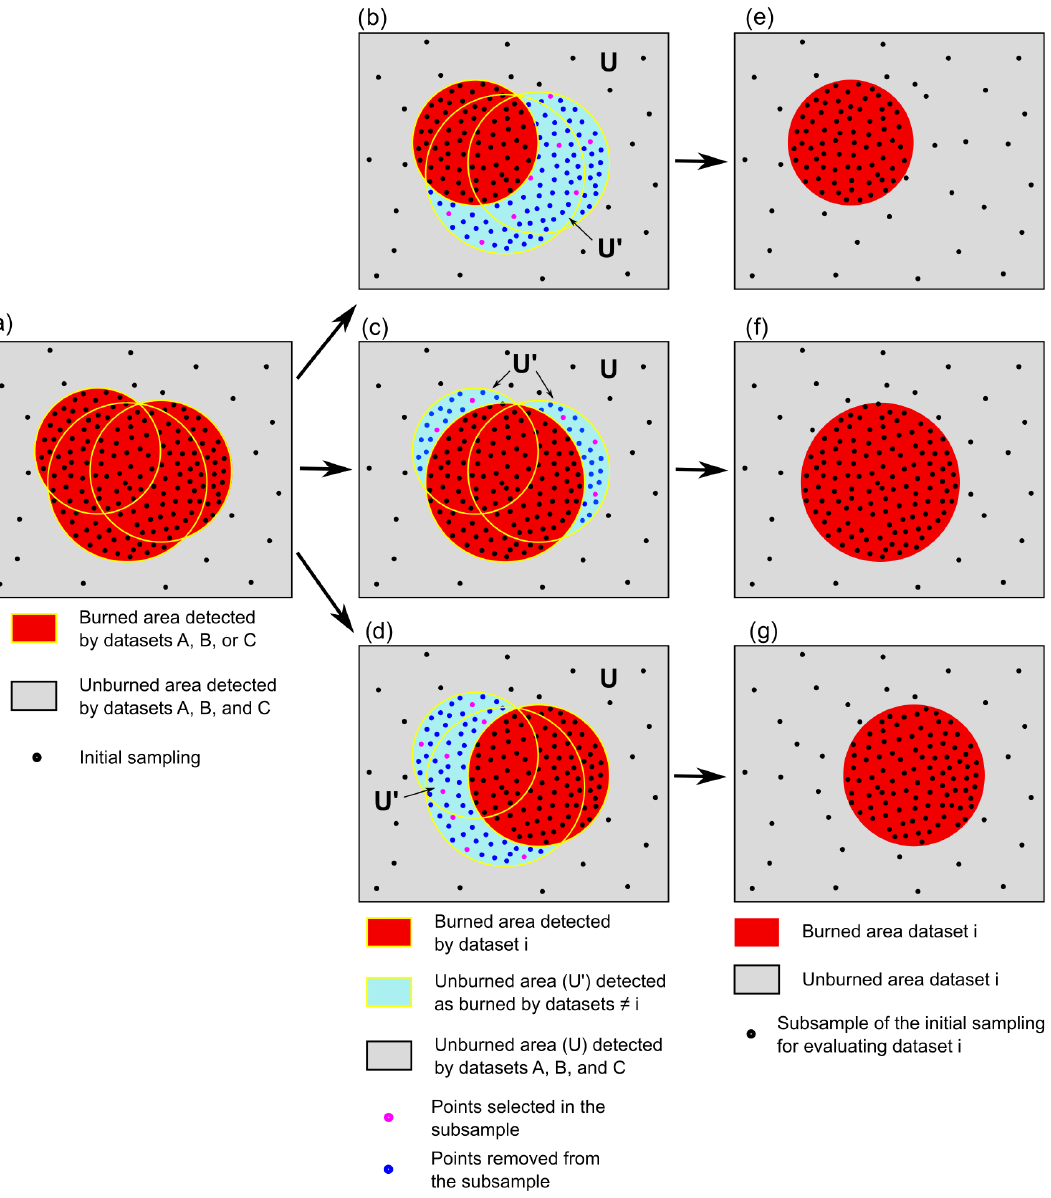
Figure 3. Representation of the adjusted stratified-sampling design for the validation of three burned-area datasets (A, B, and C) against reference sites (dots). Panel (a) shows the stratified random sampling of reference sites (black points) over the combined burned area. Note that the density of samples is higher in the combined burned area than the unburned area. Panels (b–d) show, in cyan, the area U (cid:48) , being classified as unburned in a given dataset i but classified as burned in at least one other datasets (cid:54)= i . For a given validation of A, B, and C, the sample points in the corresponding area U (cid:48) (b–d) were randomly excluded until the sampling density in the area U (cid:48) equalled that of the larger unburned area U (area in grey). Panels (e–g) show the three final adjusted, stratified subsamples of reference points derived from the initial sample of 1298 reference points. Note that the relative areas and number of sites per class in Fig. 3 do not correspond to the actual datasets being